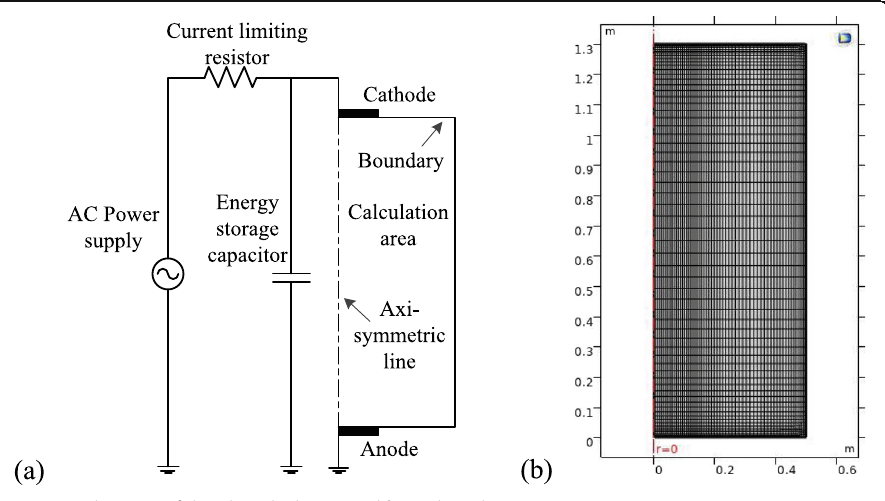
Fig. 4 a Schematic of the glow discharge, and b mesh